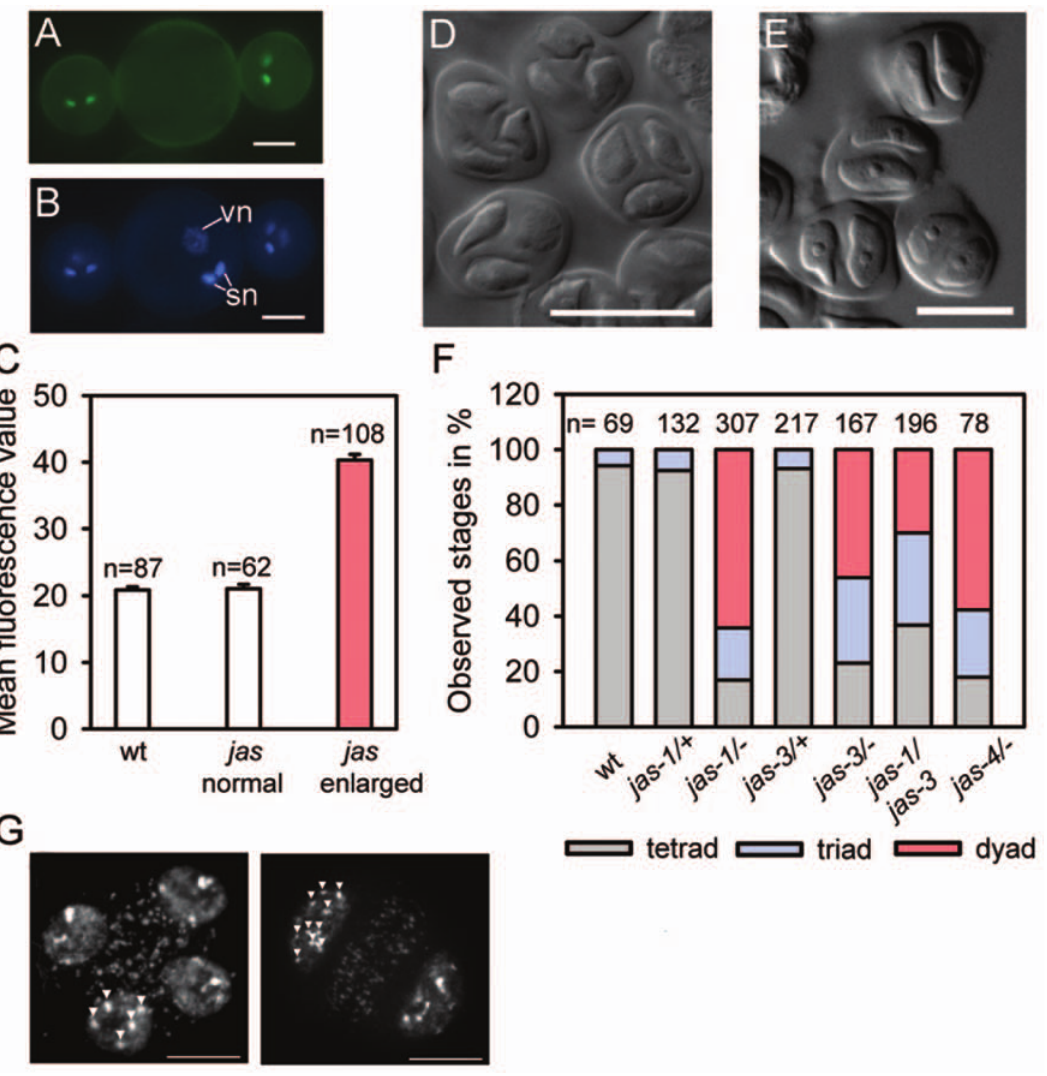
Figure 3. Homozygous jas plants form dyads and enlarged diploid pollen. (A) Pollen from jas plants was mixed with wild-type pollen marked by the sperm cell marker MGH3::H2B-GFP [65]. GFP negative enlarged pollen grain is derived from jas plants. Scale bar, 10 m m. (B) DAPI staining of pollen shown in panel (A). Enlarged jas pollen contains two sperm nuclei (sn) and one vegetative nucleus (vn). (C) DNA content of sperm cells in mature pollen from wild type and jas plants. Bars show mean relative DNA contents (DAPI fluorescence values) for pollen from wild type (WT) or jas plants, with jas pollen classified on the basis of size; normal sized ( jas ) or enlarged ( jas enlarged). The mean fluorescence from the enlarged pollen was approximately twice that of the wild type and normal sized jas pollen, indicating that it has twice the DNA content. wt; wild type. (D) Tetrad formation in wild-type plants. Scale bar, 25 m m. (E) Dyad formation in jas plants. Scale bar, 25 m m. Scale bar, 10 m m. (F) Quantification of meiotic products in L er wild-type, jas-1/ + , jas-1/ 2 , jas-3/ + , jas-3/ 2 , jas-1/jas-3 and jas-4/ 2 . Numbers on top of columns indicate numbers of analyzed meiotic products. Triads observed in wild type are most likely caused by spore superposition. (G) Chromosomal spreads of wild-type tetrad (left panel) and jas dyad (right panel). Chromosomes are marked by arrow